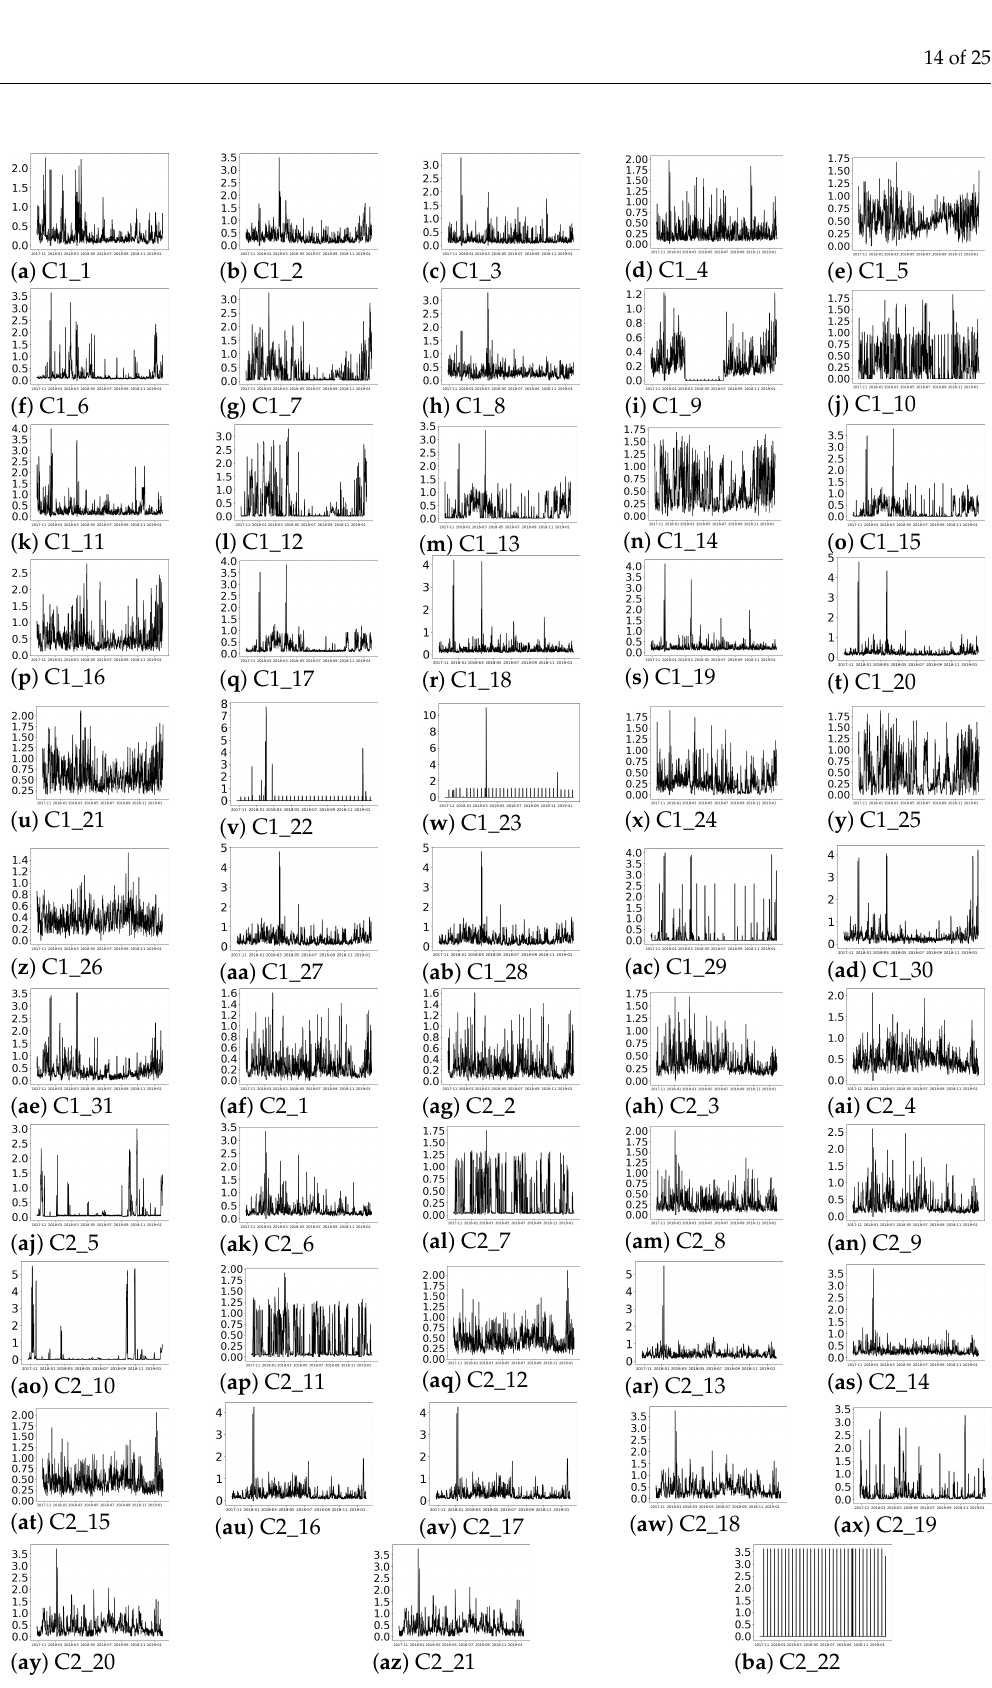
Figure 6. Rolling standard deviation with a window of size 24. Figure 5a,ba reflect that no seasonality—in terms of repeating patterns—are observed over time, which is in accordance with the results shown in the auto-correlation plots in Figure 4. In terms of trend, as concluded from values depicted in Table 2, there was no evidence for rejecting the tendency test except for 17 time series. In the presence of